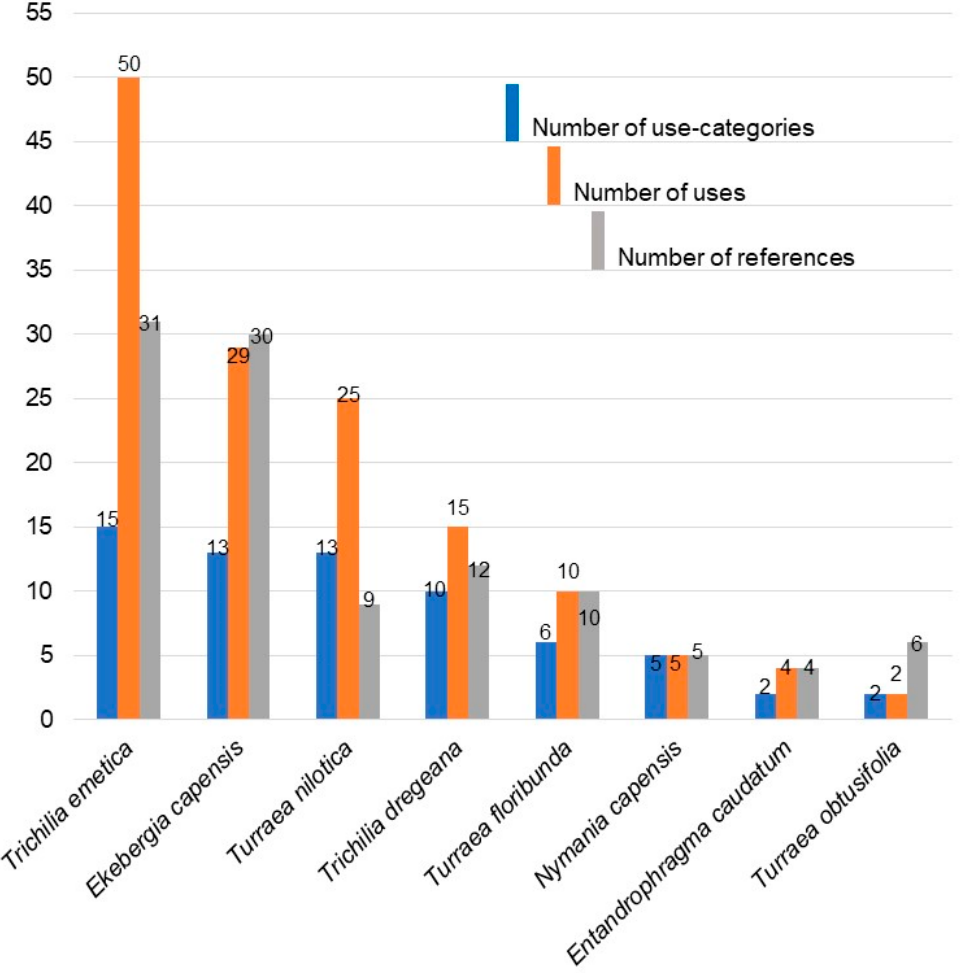
Figure 1. Number of use-categories, uses, and references for each species of South African Meliaceae.